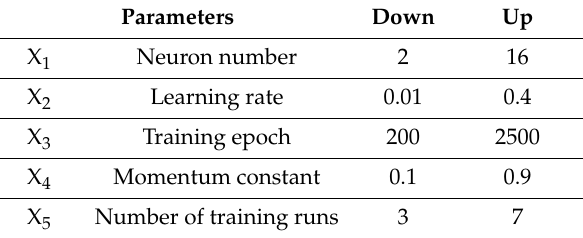
Table 2. Limits of input variables in the neural network